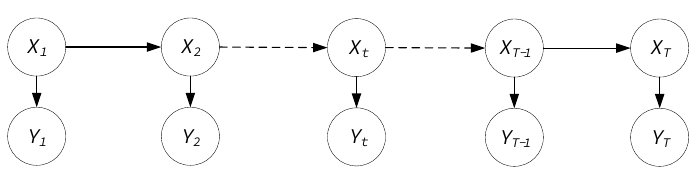
Figure 6. Hidden Markov model.